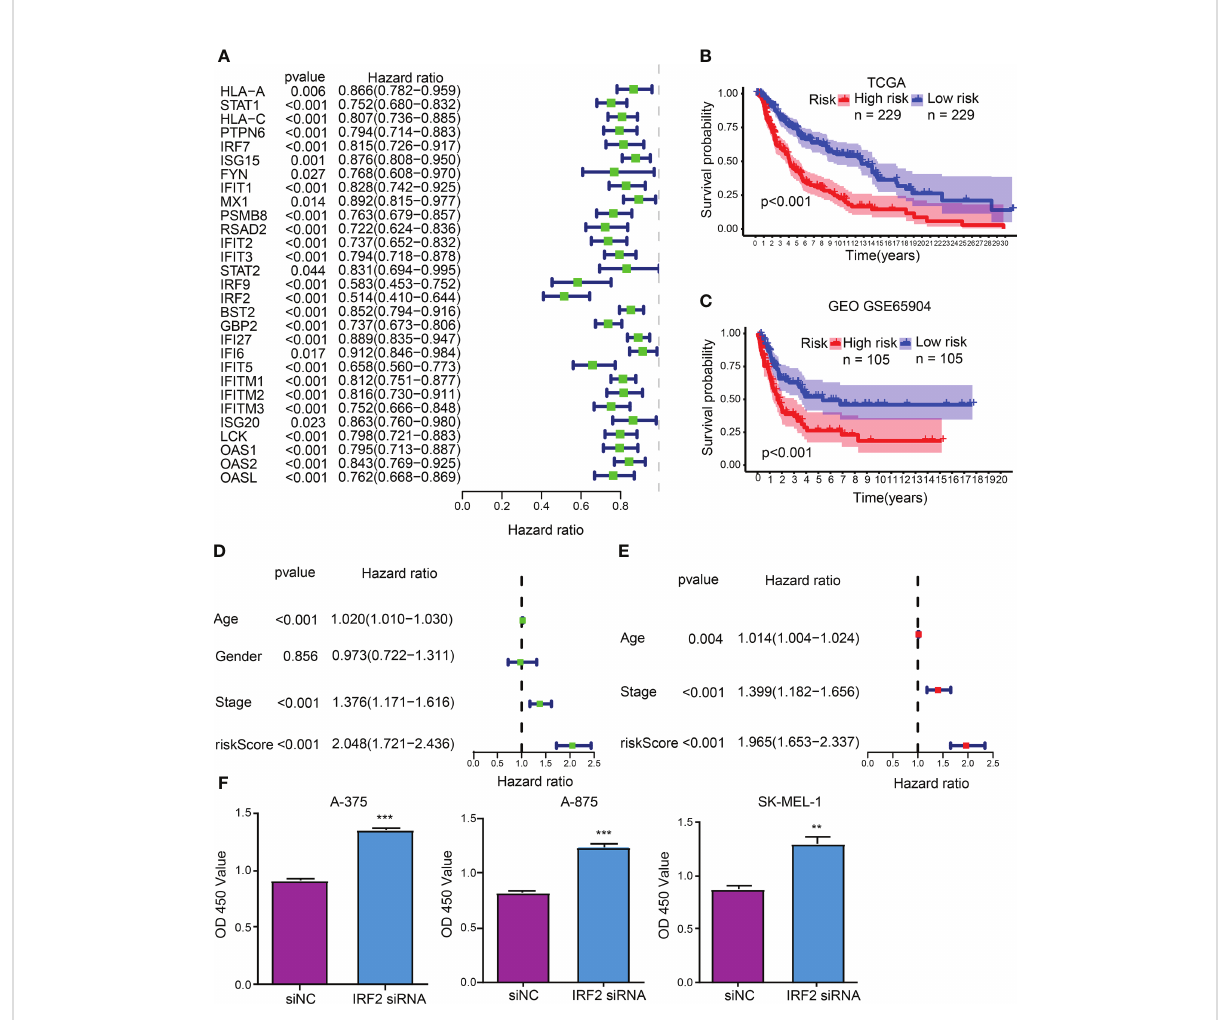
FIGURE 2 CDIGPM. (A) 29 hub CDIGs show remarkable relevance to OS according to univariate Cox regression analysis. (B) Kaplan-Meier survival analysis of high- and low-CDIGPM groups in the TCGA cohort. (C) Kaplan-Meier survival analysis of the high- and low-CDIGPM groups in the GEO cohort. (D) Univariate Cox analysis of clinical factors and the CDIGPM. (E) Multivariate Cox analysis of the factors signi fi cant in the univariate Cox analysis. (F) Cell proliferation of SKCM cells transfected with IRF2 siRNA or siNC. (**p < 0.01, ***p < 0.001). CDIGs: CD8 + T cells-associated immune genes, CDIGPM: CD8 + T cells-associated immune genes prognostic model, siNC: siRNA negative